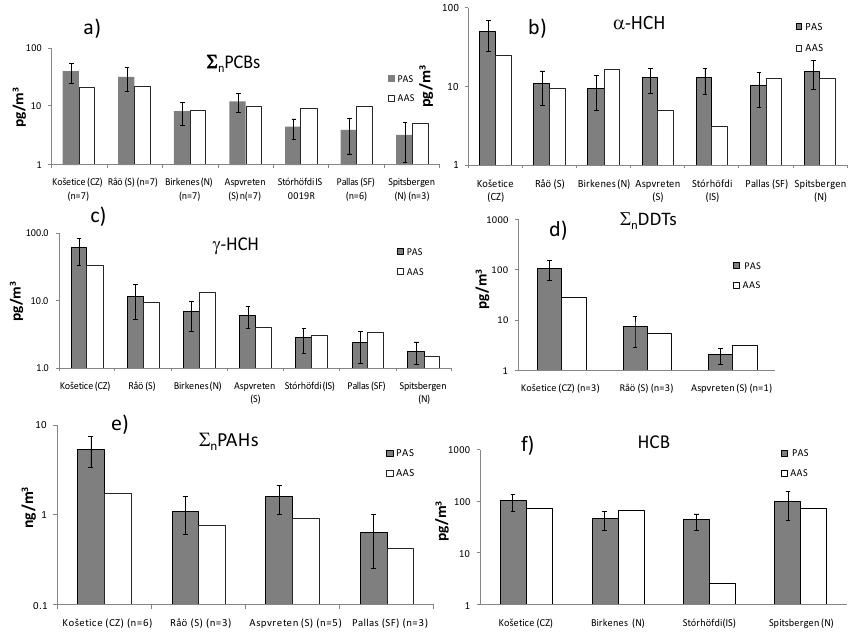
Fig. 1. (a) – (f) : Comparison of results obtained on the basis of PAS (average of two parallels) and AAS (see text for details).